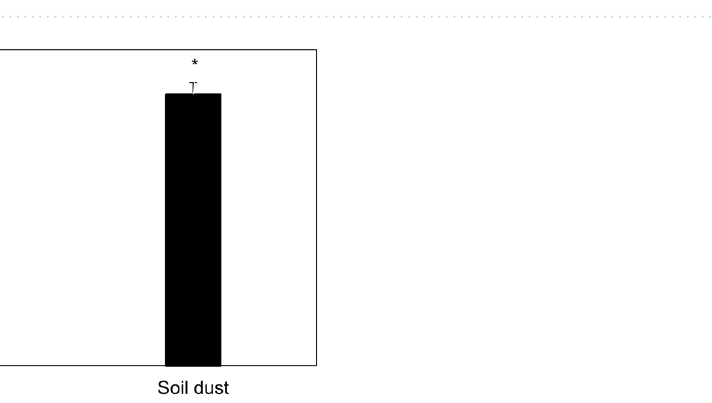
Figure 2. The effect of soil dust application on the content of malondialdehyde (MDA) ( a ) and the total phenolic content (TPC) ( b ) in lettuce grown under hydroponic conditions. Significant differences between treatments are indicated by asterisks (ANOVA; Fisher’s LSD test; p ≤ 0.05). Columns without asterisks are not significantly different.